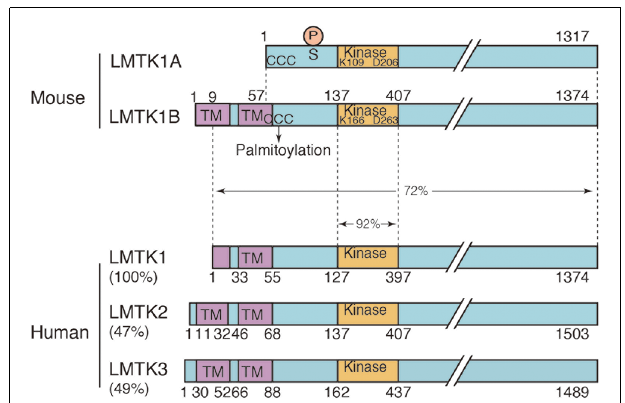
FIGURE 1 | Domain structure of the two isoforms of mouse lemur tail (former tyrosine) kinase 1 (LMTK1) and human LMTK1-3. Mouse LMTK1A and LMTK1B are alternatively spliced isoforms of LMTK1 that consist of 1,317 and 1,374 amino acids, respectively. The kinase domain (Kinase) is present in the N-terminal region with the long C-terminal tail. The amino acids Lys (K) and Asp (D) that are essential for the kinase activity are conserved. LMTK1A is a cytosolic protein that binds to the cytoplasmic surface of endosomal membranes via palmitoylation at N-terminal three cysteines (ccc). LMTK1B is a transmembrane protein with two transmembrane sequences at the N-terminus, which is also suggested to be palmitoylated at cysteines (ccc). The Cdk5 phosphorylation site is Ser34 of LMTK1A. Human LMTK1-3 is shown below the mouse LMTK1. Human LMTK1 is translated from the methionine in the first transmembrane sequence according to the amino acid sequences (NCBI accession number: NP_001073864.2). While the identity of the kinase domain is 92%, the identity of the full-length protein is 73% between mouse and human LMTK1, which is a relatively low value. Human LMTK2 (NCBI accession number: NP_055731.2) and LMTK3 (NCBI accession number: NP_001073903.1) are also shown below with % homology to human